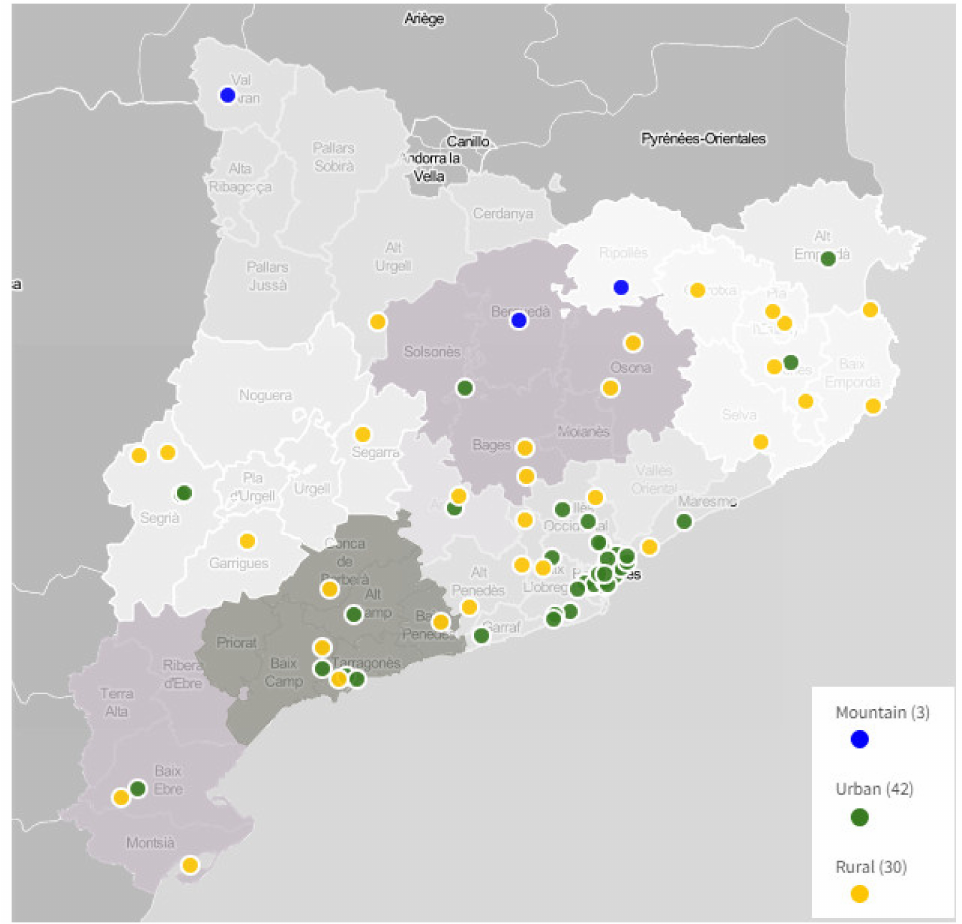
Figure 2. Map of the final territorial distribution of the 75 pharmacy offices of the sentinel pharmacy network of